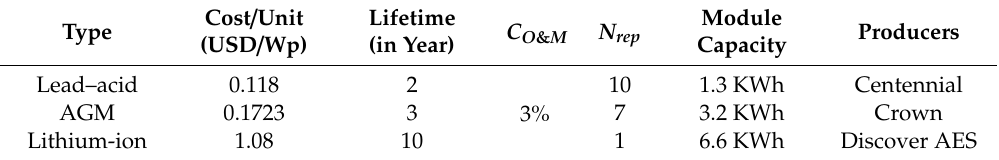
Table 2. Financial data of the three types of storage batteries